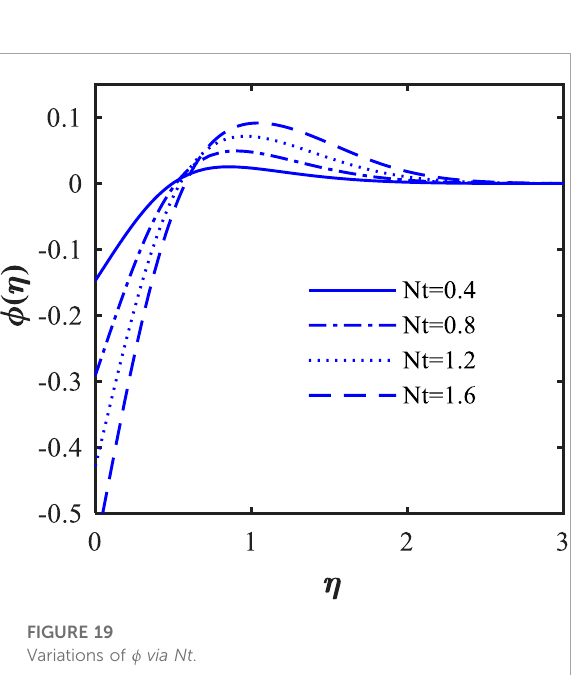
FIGURE 21 Variations of ϕ via Nb